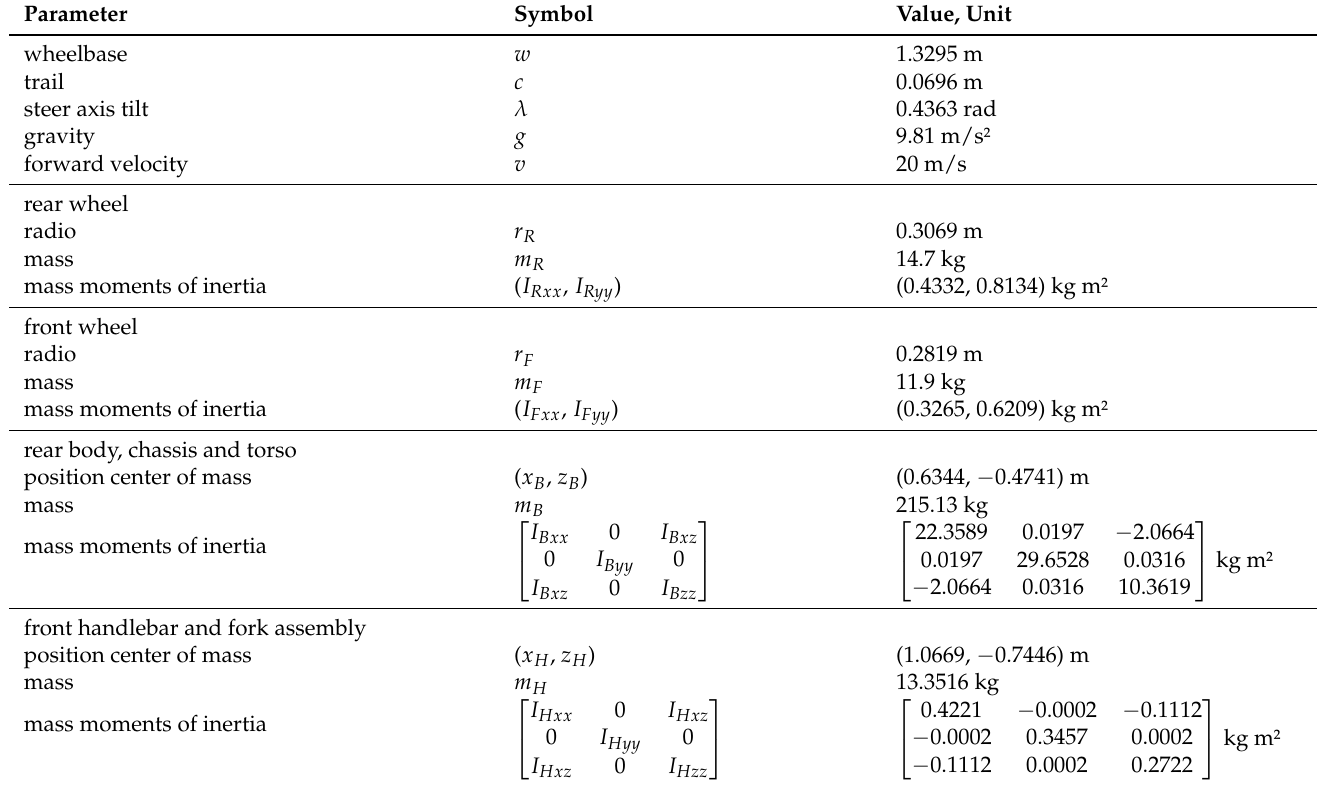
Table 2. Whipple’s model parameters